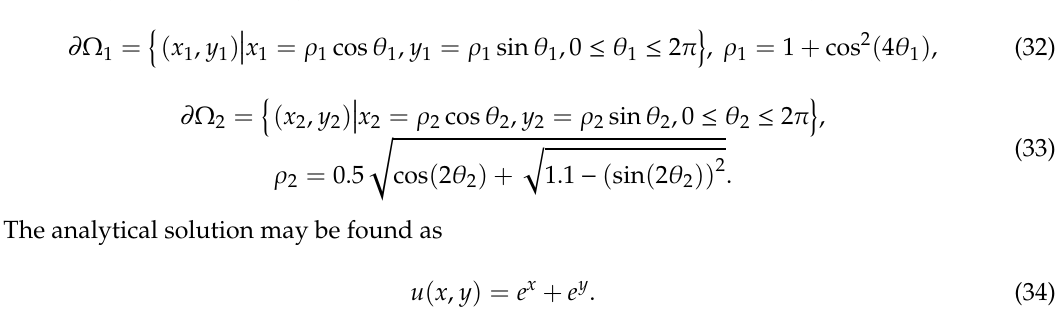
Figure 15. Results comparison between this study and the analytical solution.